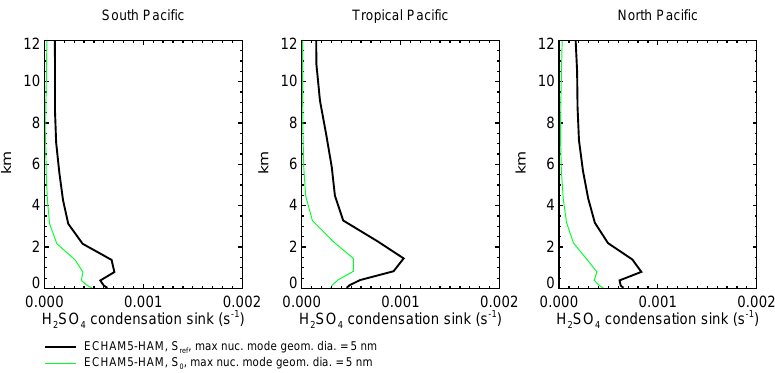
Fig. 3. Comparison of annual mean aerosol H 2 SO 4 condensation sink from simulation S ref (black) with S 0 (green) in three regions of the Pacific Ocean.